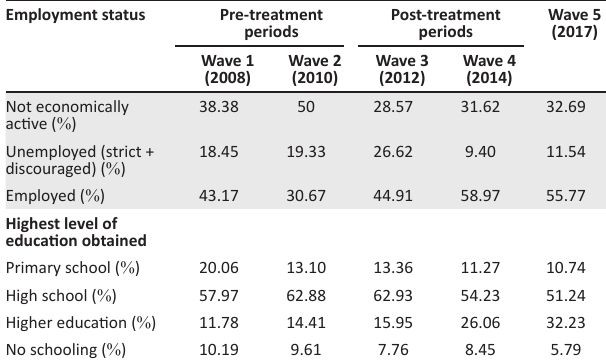
TABLE 3: Changes in employment and education statistics of migrants throughout the